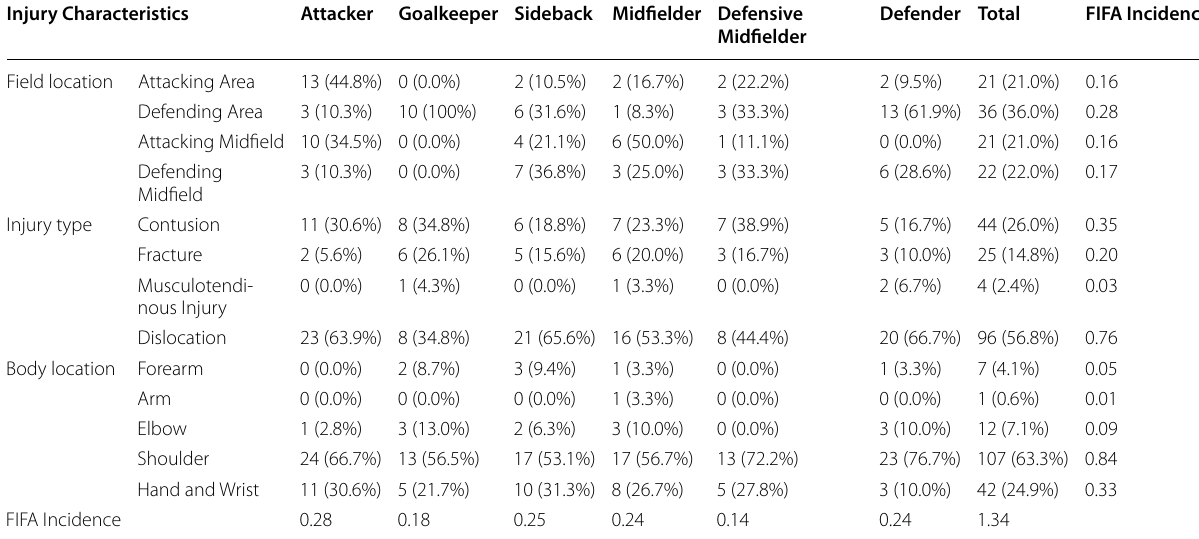
Table 2 Incidence of upper limb injuries by player position, field location, type of injury related to the FIFA incidence